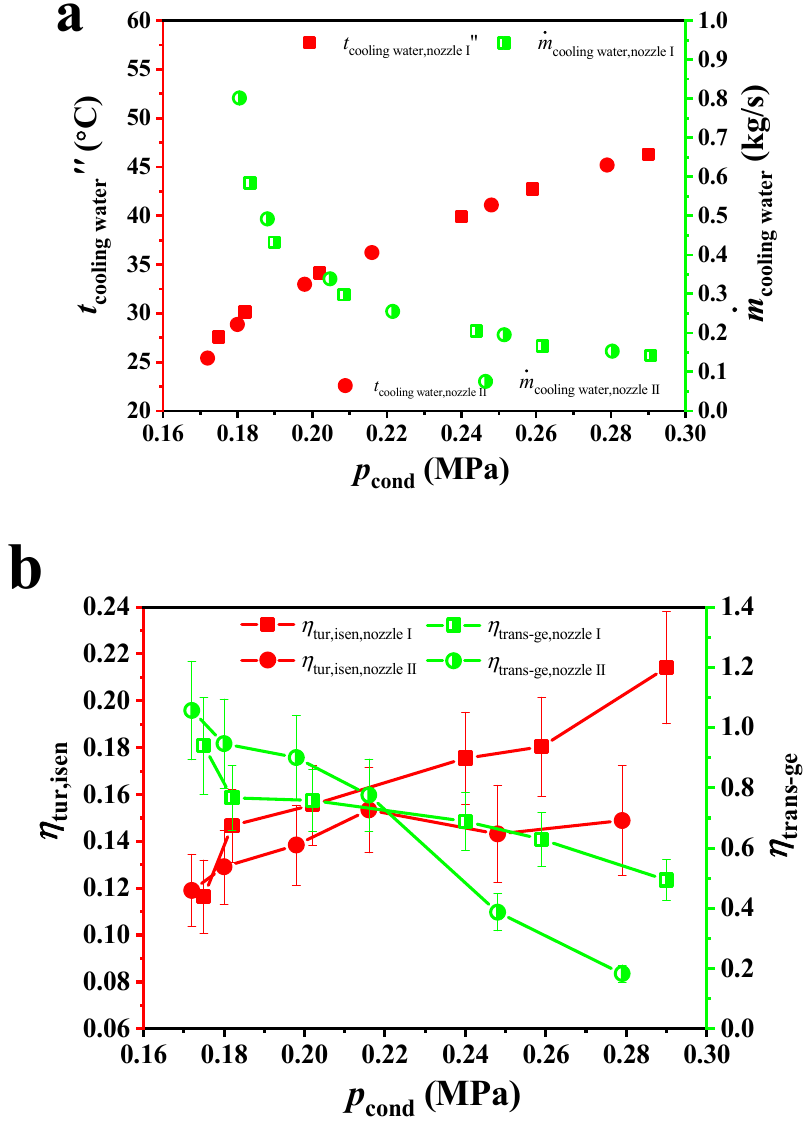
Figure 9. Variation of system performance with condensing pressure (R245fa). ( a ): Parameters about the cooling water; ( b ): Efficiency about the turbine and the generator.